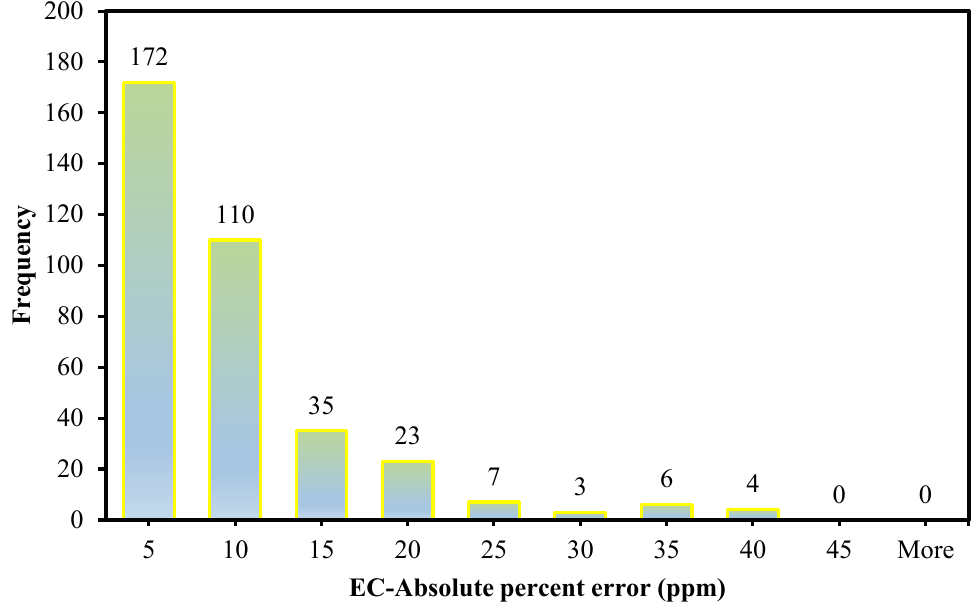
Figure 5. Histogram representing the percent error ranges of MEP-EC model. Table 5. Statistical error measurement of non-linear regression models developed for EC and TDS.